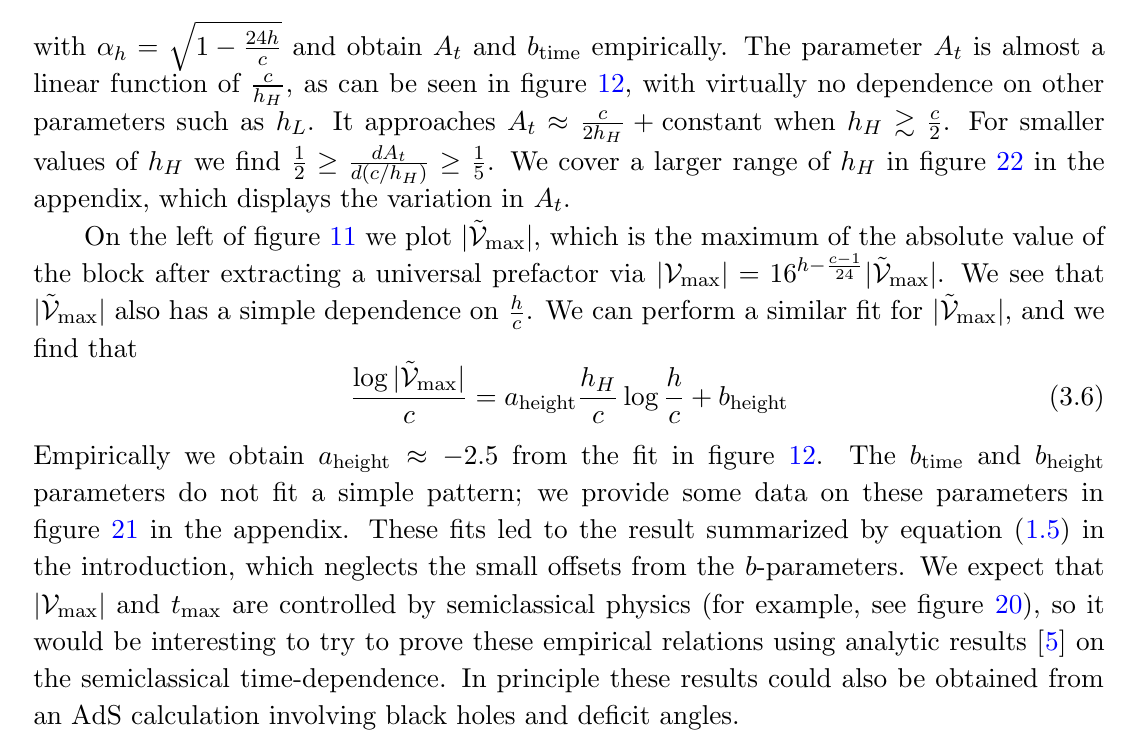
Figure 9 . This (cid:12)gure displays the time t d at which the semiclassical vacuum blocks drop below the exact vacuum blocks. The dashed line is a (cid:12)t to the analytic prediction t D o(cid:11)set t d = t D 2 : 6; the o(cid:11)set depends on the choice of r with z = 1 (cid:0) with smaller values of c is noisy, but the larger values (cid:12)t the linear behavior extremely well. The plot includes a variety of choices for h H c